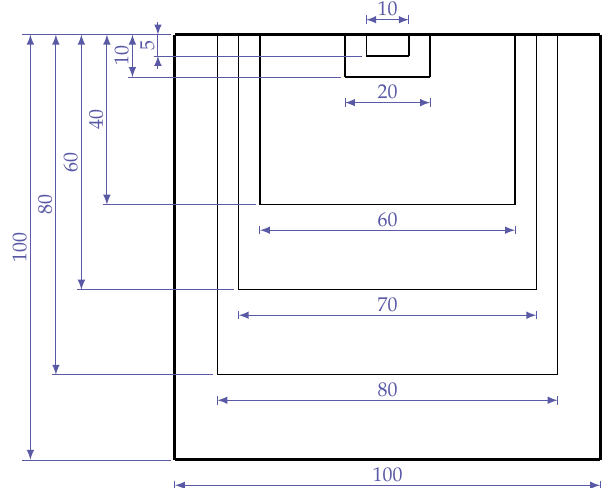
Figure 3. 2D cut-plane of the fine mesh used in this work. Each box corresponds to a specific refinement region. The dimensions are expressed in